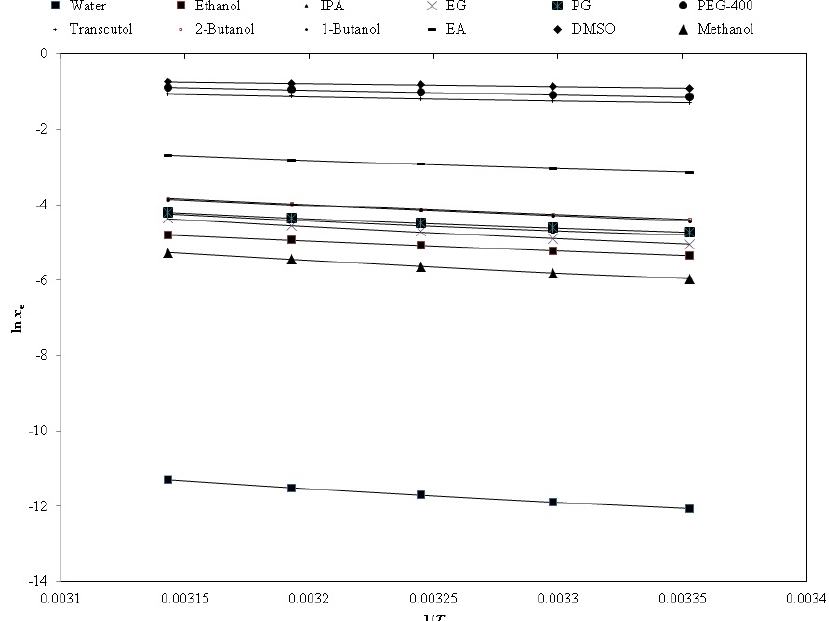
Figure 4. The correlation of the experimental natural logarithmic solubilities (ln x e ) of PPD with the “Apelblat model” in various neat solvents as a function of 1 / T ; the symbols represent the experimental ln x e values of PPD, and the solid lines represent the ln x Apl values calculated by the “Apelblat model”.